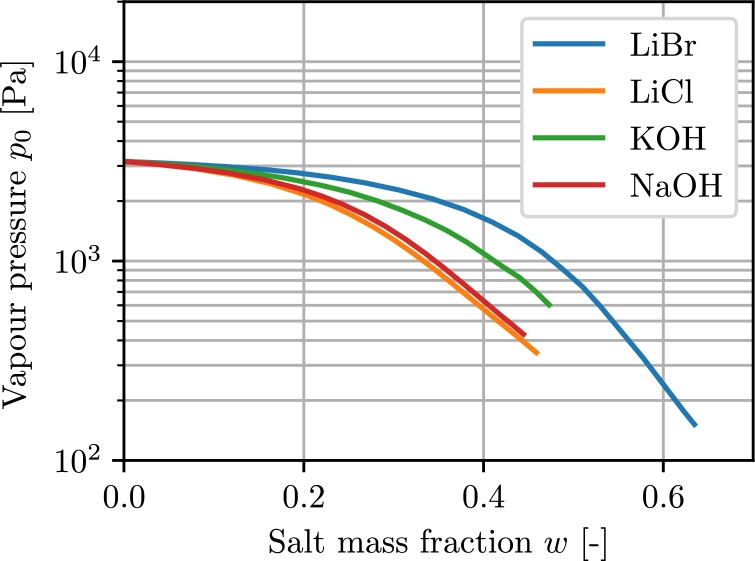
Vapour pressures for selected absorbents at 25 ∘C. Derived from [11, pp. 395-396].